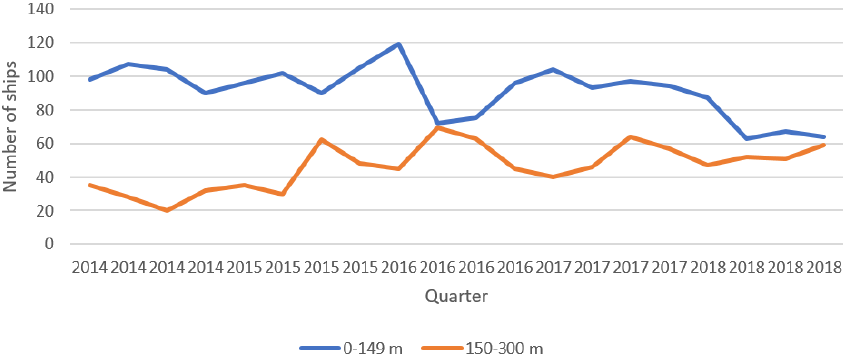
Figure 7. The sizes of ships arriving at the port of Norrköping.